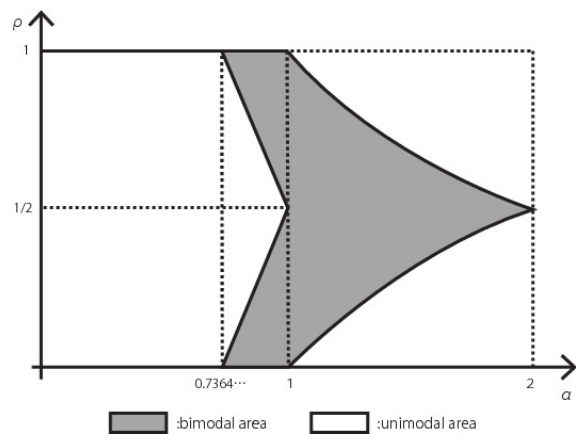
Fig. 3. Unimodality of boolean stable distributions